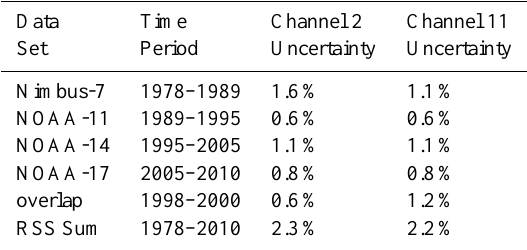
Table 1. Long-term albedo uncertainty at selected wavelengths for hypothetical merged V8.6 ozone data